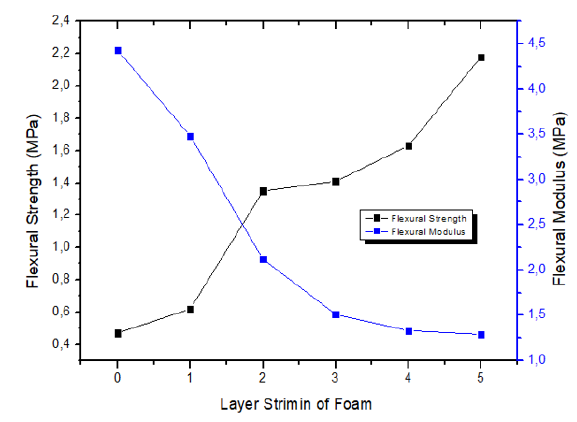
Fig. 5. Flexural Properties of Core